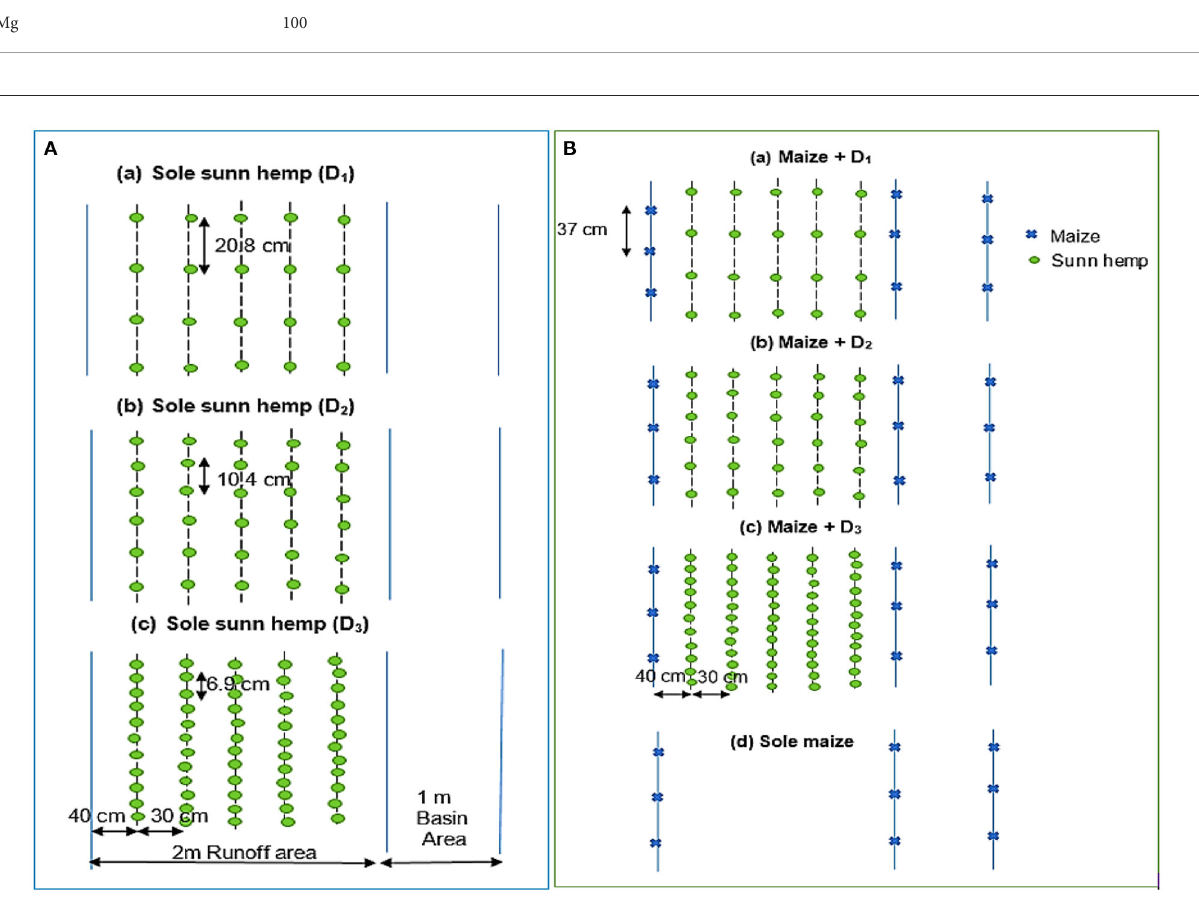
FIGURE1 The spatial arrangement for living mulch cover crop planting density. (A) (a) Sole sunn hemp at D1 (16.1 plants m − 2 ); (b) sole sunn hemp at D2 (32.1 plants m − 2 ); (c) sole sunn hemp at D3 (48.1 plants m − 2 ). (B) (a) Maize + sunn hemp at D1 (16.1 plants m − 2 ); (b) maize + sunn hemp at D2 (32.1 plants m − 2 ); (c) maize + sunn hemp at D3 (48.1 plants m − 2 ); (d) sole maize.